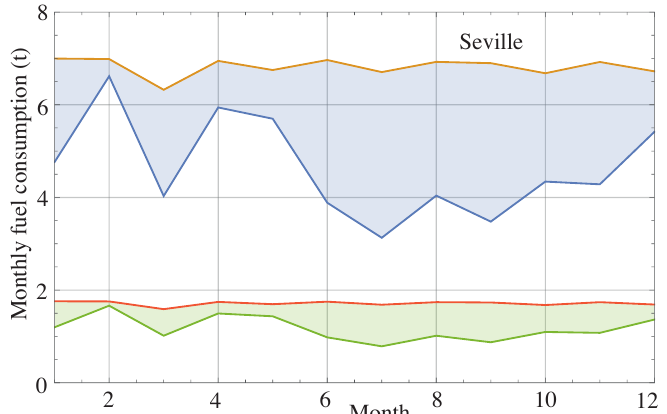
Figure 11. Monthly fuel consumption on the basis of natural gas fueling. Shaded areas represent the total annual savings when comparing between a purely fuel combustion mode (natural gas burning) and the hybrid mode. All cases are